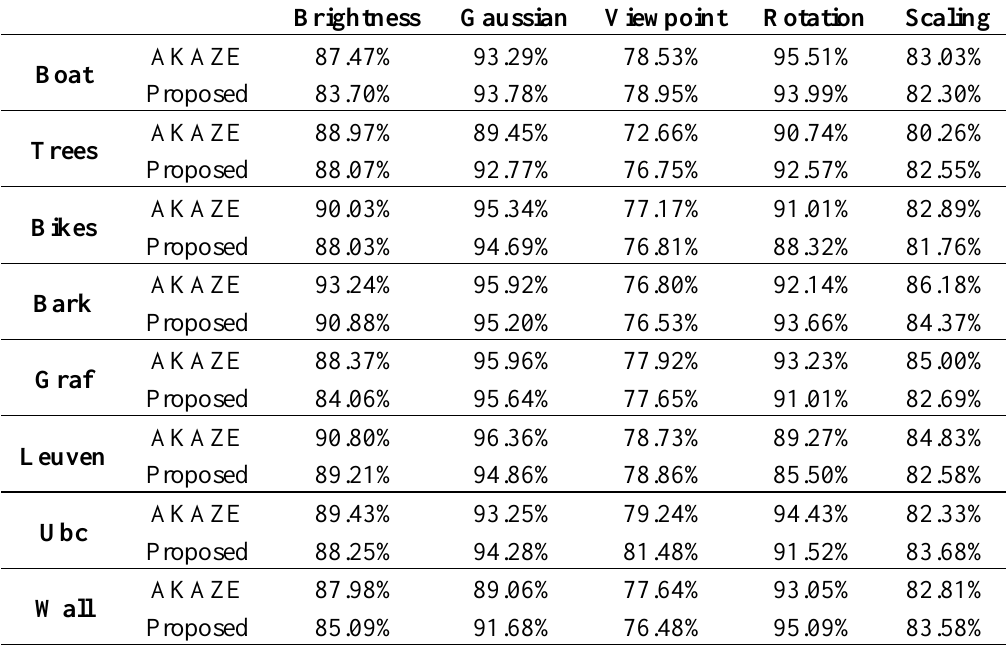
Figure 10. Feature matching results. Table 2. Comparison of average matching